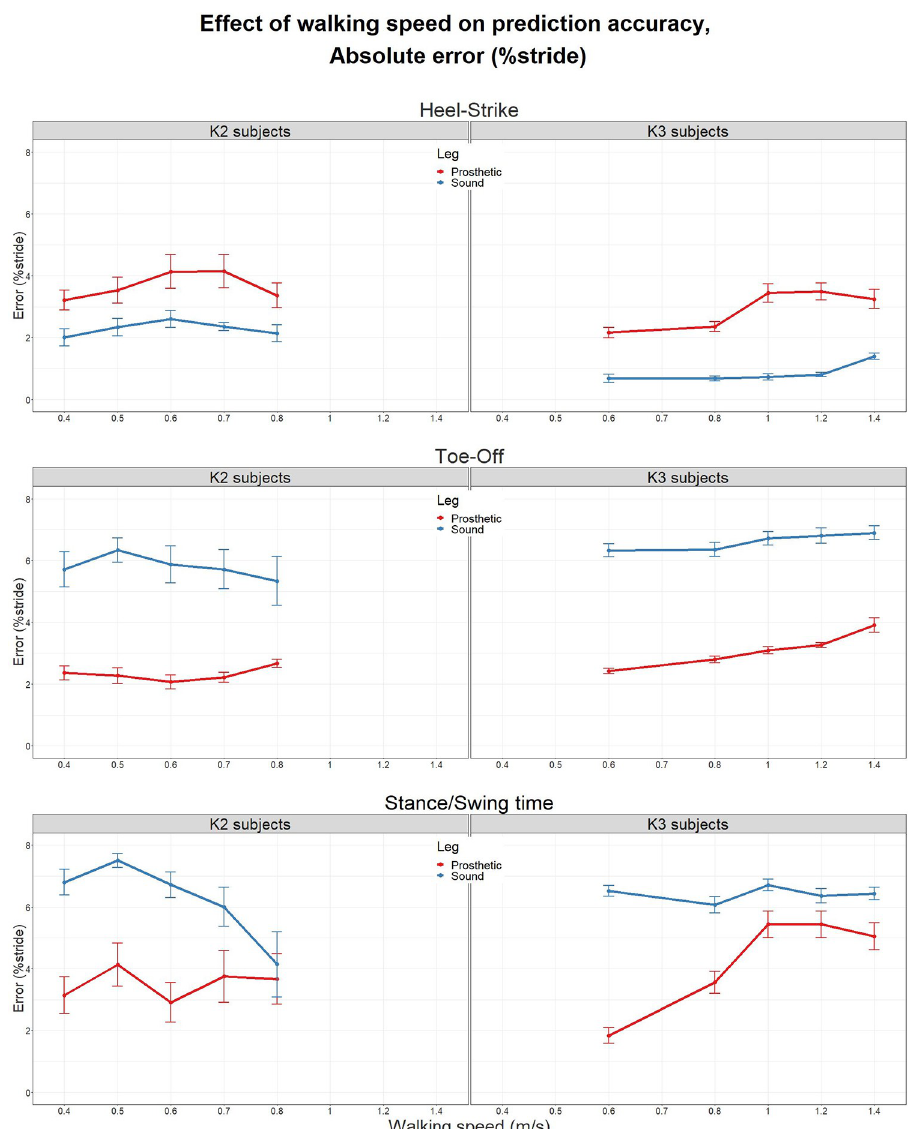
Fig 4. Speed-wise heel-strike (top), toe-off (middle), and stance/swing time (bottom) absolute error values, further separated by subject groups (left: K-level 2 subjects and right: K-level 3 subjects) and leg side (blue: sound, red: